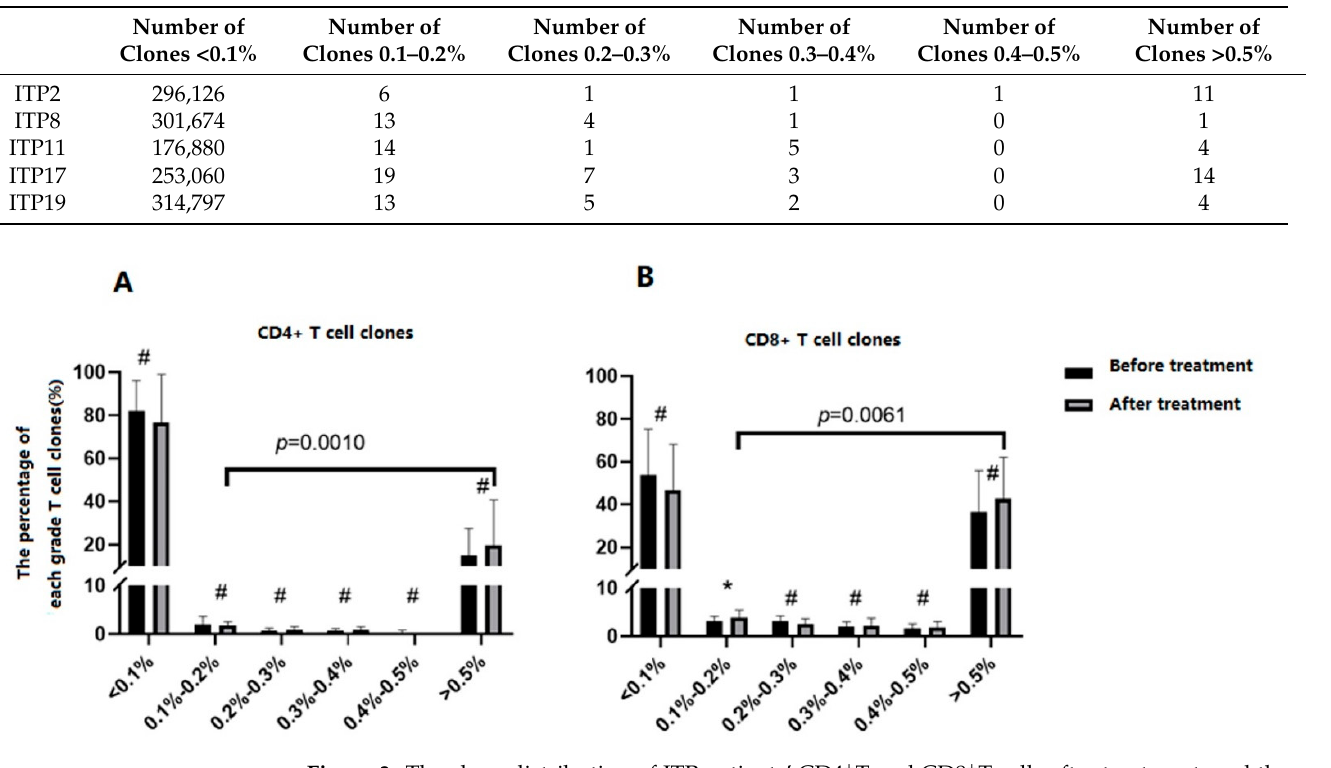
Table 5. The distribution of CD4 + T cell repertoire in peripheral blood after treatment.